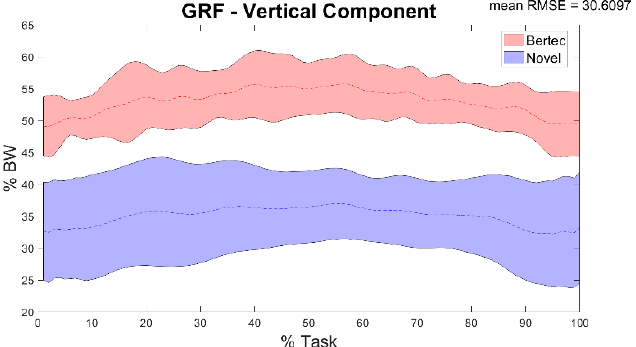
Figure 4. Vertical component of the GRF during the task recorded through the force plates (Bertec— red), and through the plantar pressure system (Novel—blue) and mean of RMSE% of the comparison between the two. Averages plus and minus one standard deviation are reported as colored bands.